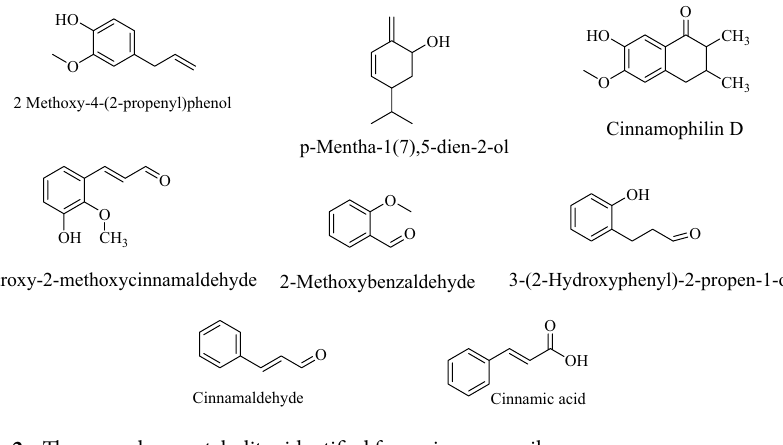
Figure 2. The secondary metabolites identified from cinnamon oil.